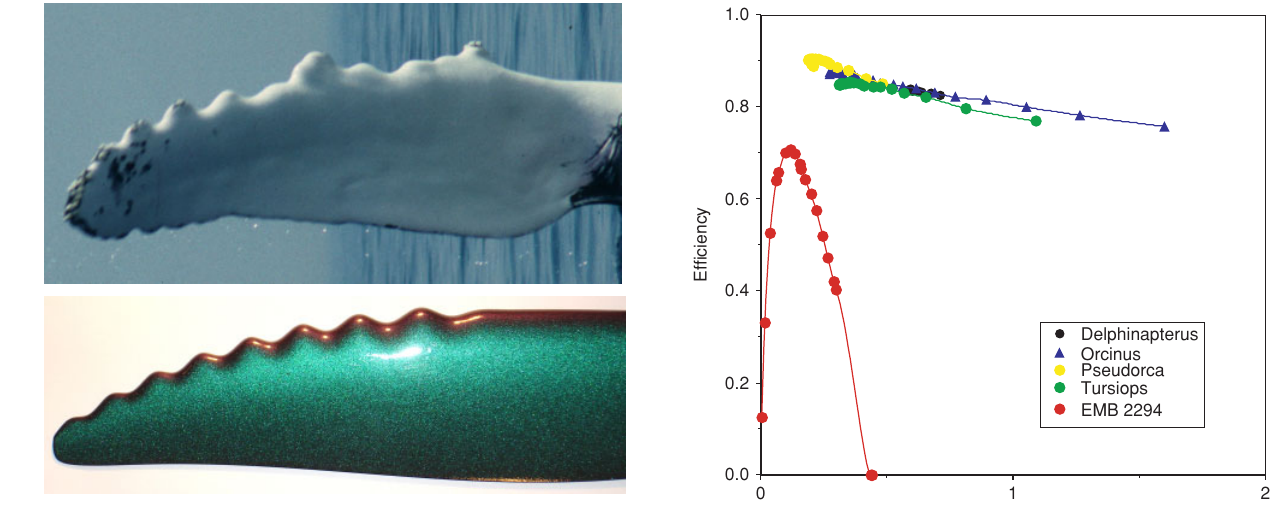
Figure 2 Actual (top) and model (bottom) flippers of humpback whale showing leading edge tubercles. Photograph of humpback whale flipper courtesy of W. W. Rossiter.